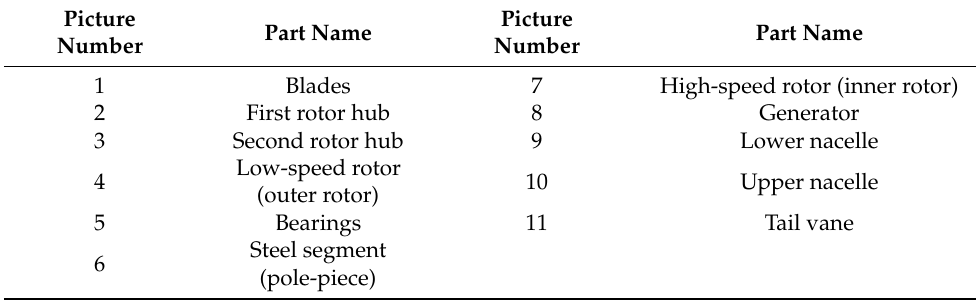
Figure 18. Sectional view of the wind turbines gearbox. Table 10. Wind Turbine